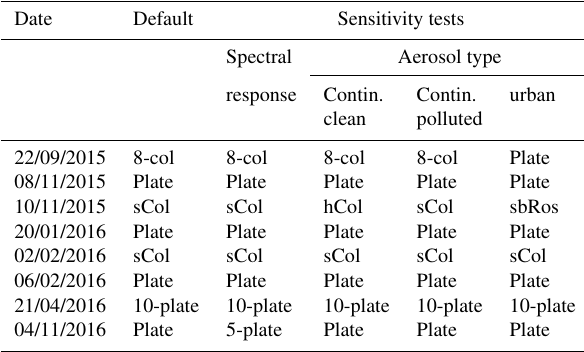
Table 4. Best match habit for the retrieval applied to HaloCam RAW daily observations for the default retrieval (first column) and consid- ering the spectral response (second column), followed by the con- tinental clean, polluted, and urban aerosol types. The habits vary between plates (plate), 5-element plates (5-plate), 10-element plates (10-plate), 8-element columns (8-col), solid columns (sCol), hollow columns (hCol), and solid bullet rosettes